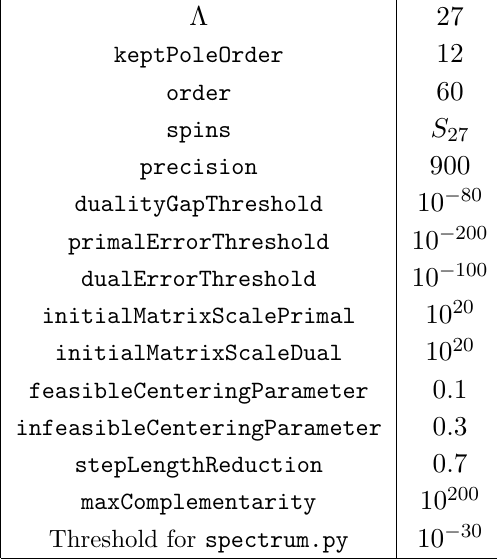
Table 2 . Parameters used for the computations of the extremal functional method, as de(cid:12)ned in [3]. We de(cid:12)ne S 27 = f 0 ; : : : ; 31 g [ f 49 ; 50 g .